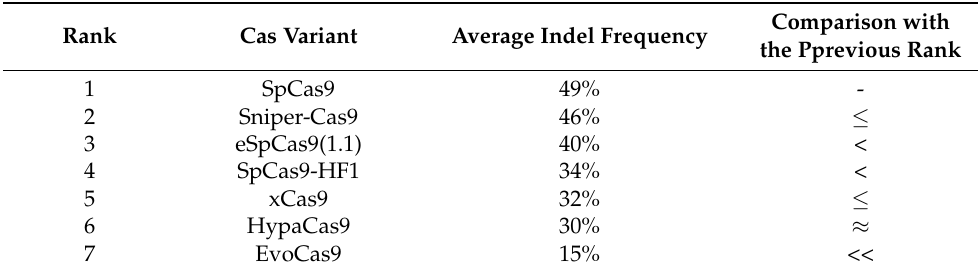
Table 6. Ranking of high-fidelity Cas9 variants according to efficiency. Adapted from Kim et al. (2020) [132].